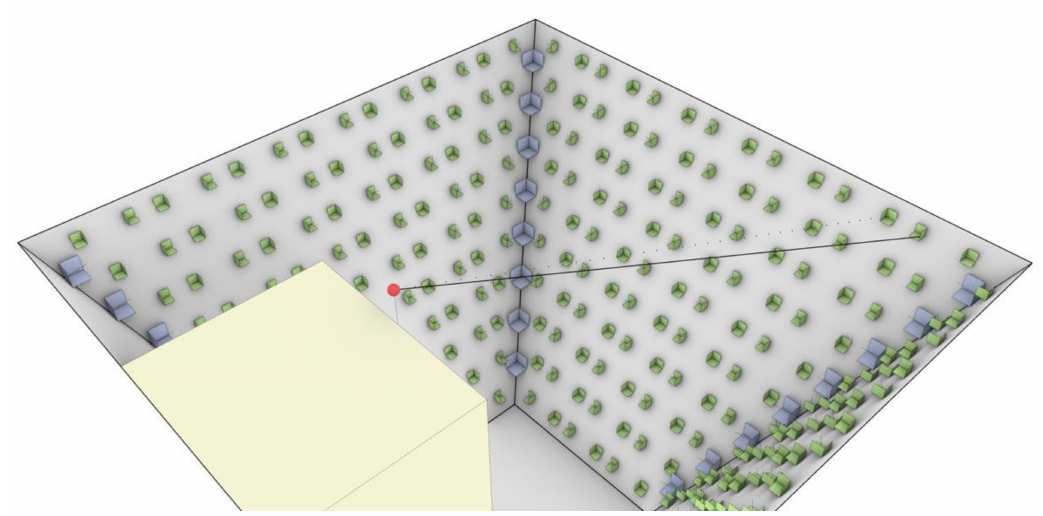
Figure A1. An example of the generic model. Green: small reflectors; blue: large reflectors; red dot: source position; grey: inverted frustum; yellow: platform. Two small reflectors connected with solid and dotted lines are examples of visible and obscured reflectors,